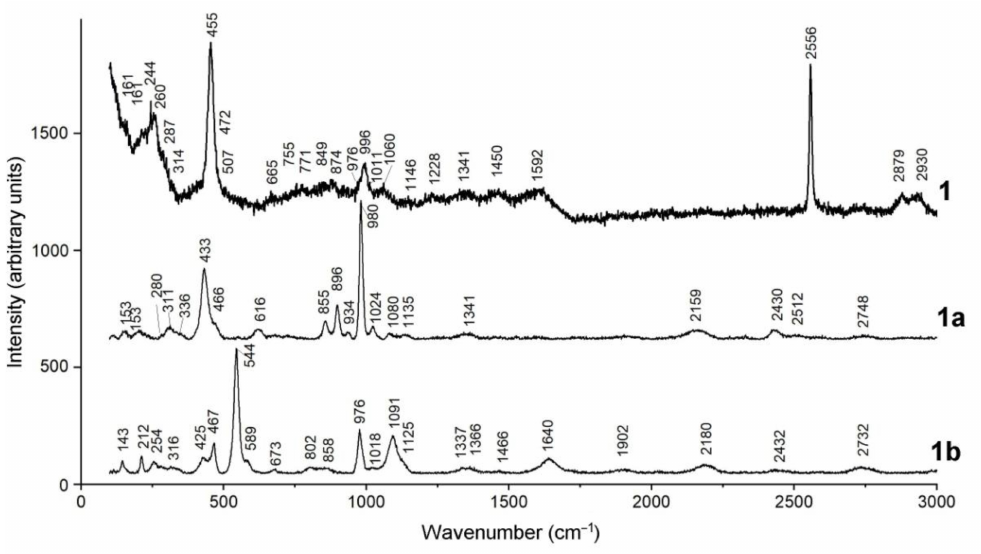
Figure 27. Raman spectra of powders obtained in Experiments 1, 1a and 1b. The description of the experimental conditions is given in Table